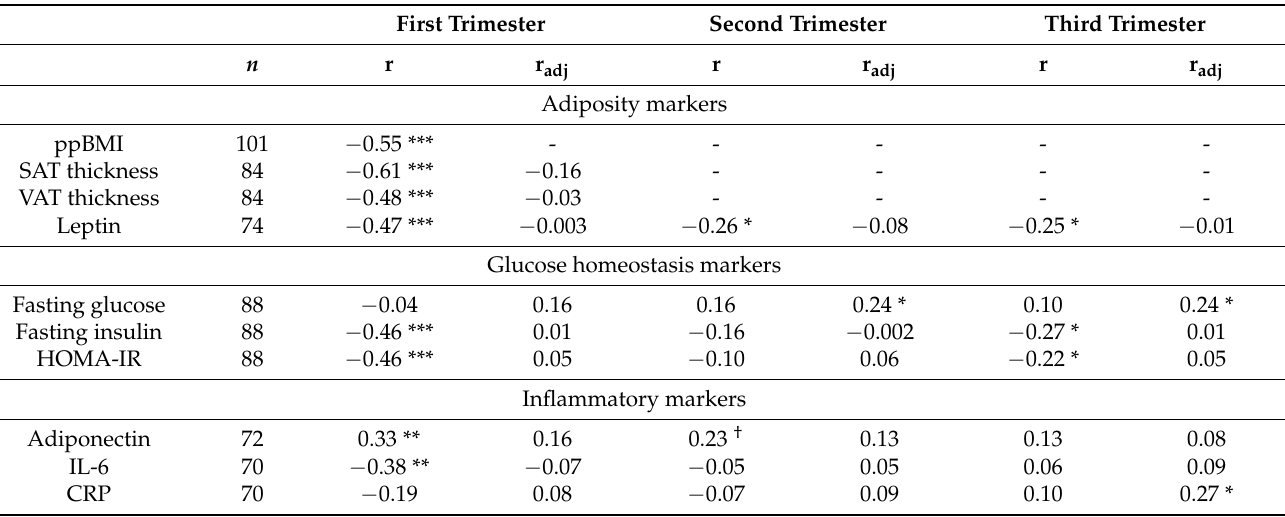
Trimester-specific associations between circulating uncorrected fructosamine and metabolic